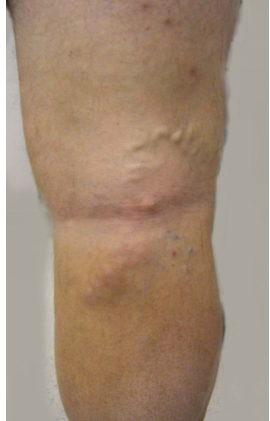
Figure 1: Photograph of leg demonstrating posterior popliteal varicosities and venous stasis pigmentation.